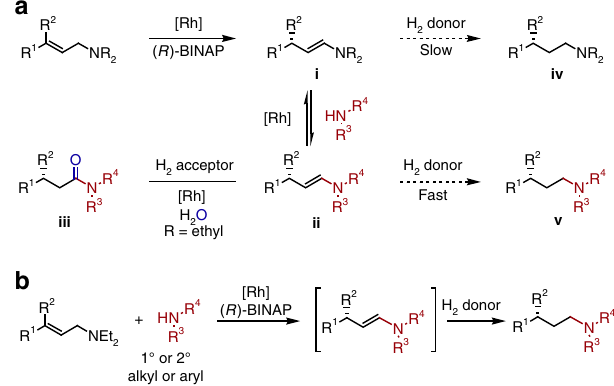
Fig. 2 Design of a tandem asymmetric isomerization — enamine exchange — reduction process. a The chemoselectivity is determined by the relative reduction rate of intermediates i and ii. When R = ethyl, exclusive formation of β -branched amide iii is observed in the presence of hydrogen acceptor.